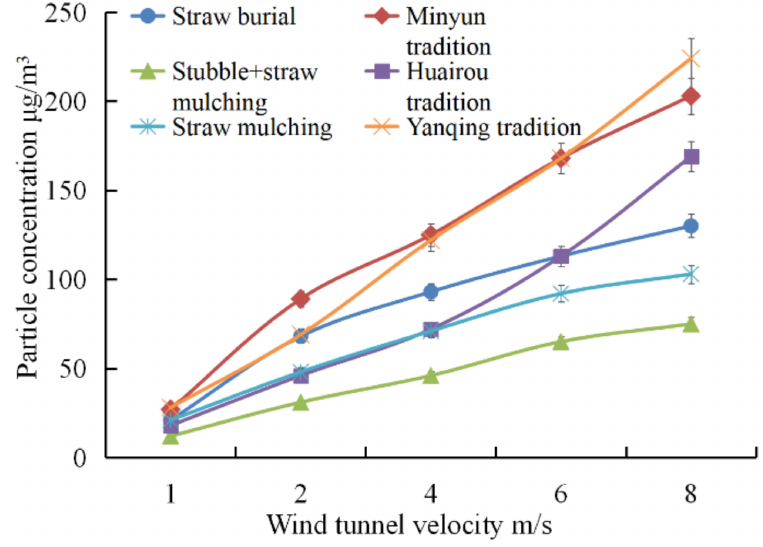
Figure 28. PM10 concentration changes with wind speed at 20 cm height in the wind tunnel.